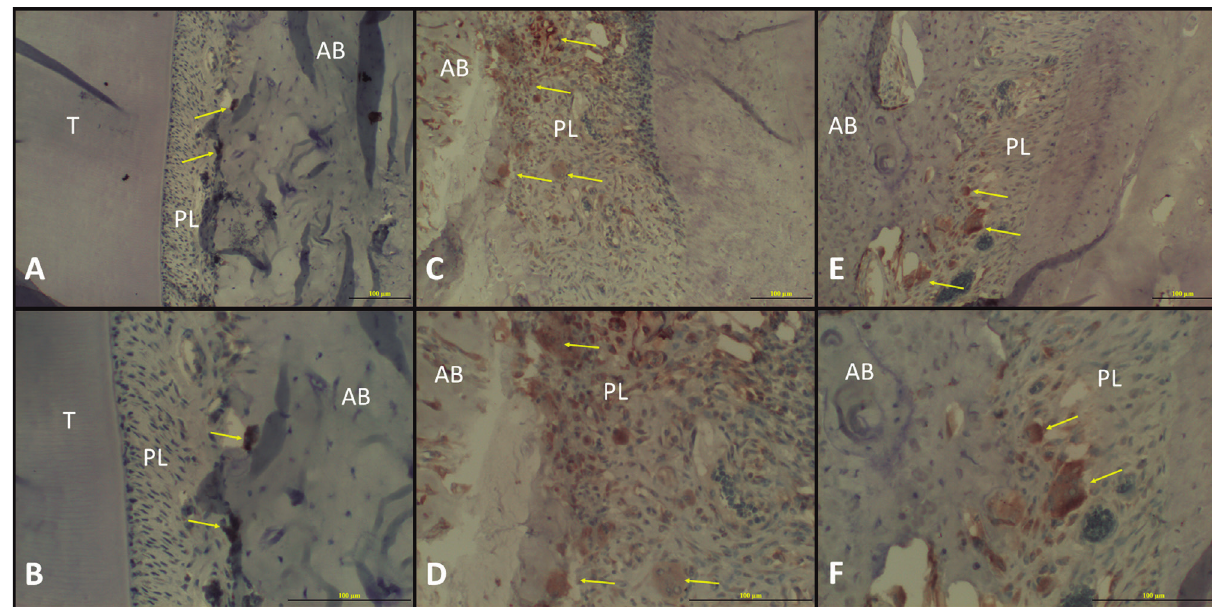
T=tooth; AB=alveolar bone; PL=periodontal ligament; NL=non-ligated; LO=ligature only; S=ligature and treated with sumac Figure 3- RANKL expressions in NL, LO, and S groups. A- RANKL expressions in NL group at 200x magnification; B- RANKL expressions (yellow arrows) in NL group at 400x magnification; C- RANKL expressions (yellow arrows) in LO group at 200x magnification; D- RANKL expressions (yellow arrows) in LO group at 400x magnification; E- RANKL expressions (yellow arrows) in S group at 200x magnification; F- RANKL expressions (yellow arrows) in S group at 400x magnification